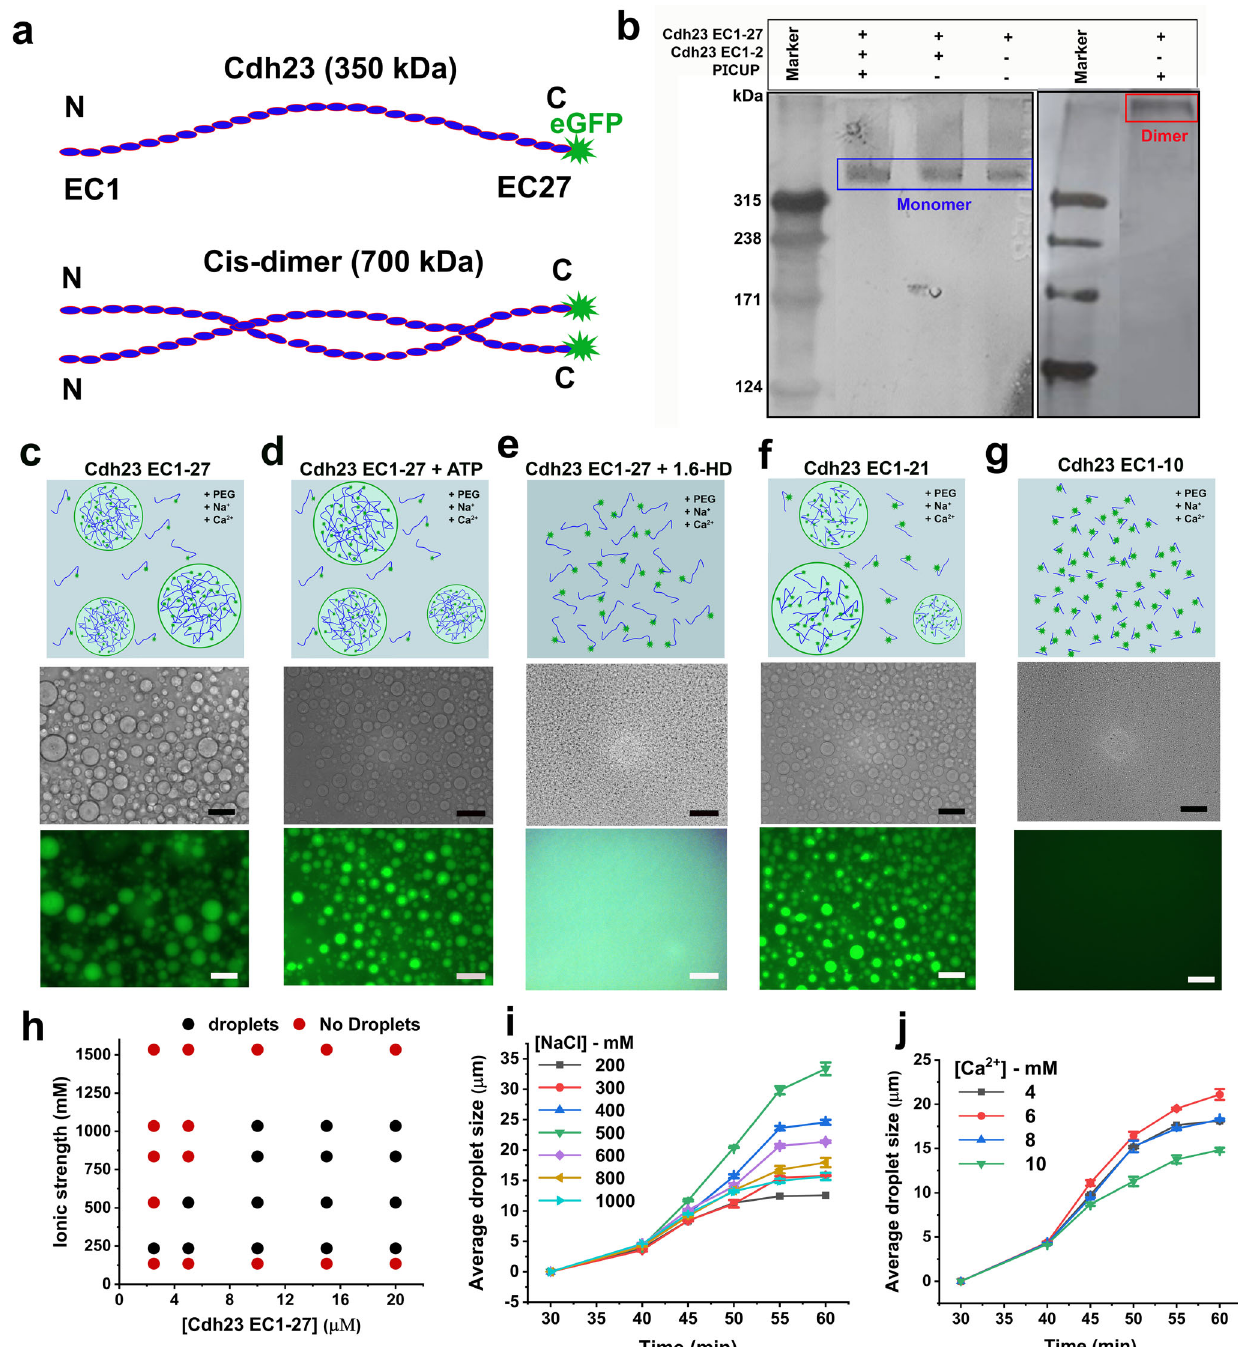
strength and speci fi city. While protein-protein complex forma- tion relies on relatively stable and speci fi c interactomes, phase separation of a protein in a solution is driven by weak, spatially distributed, transient intermolecular interactions. We observed a spontaneous formation of liquid droplets of Cdh23 EC1-27 above a critical protein concentration of 2.5 µM (Fig. 1c). The phase- separated state is stable over a range of ionic strengths (Fig. 1h). To visually track the phase separations in real-time under a fl uorescence microscope, we recombinantly tagged eGFP (enhanced Green Fluorescent Protein) at the C-terminal of Cdh23 EC1-27 (Fig. 1a). Fusion among fl oating droplets, the gold standard for liquid condensates, is also noticed among